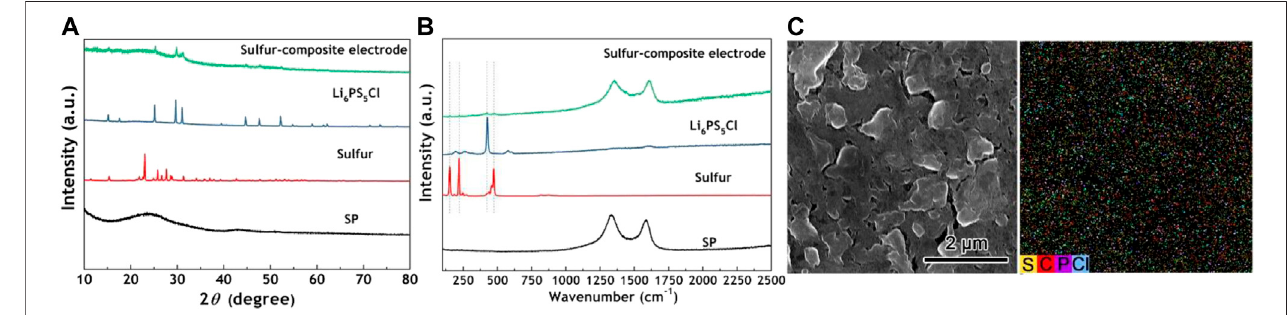
FIGURE 2 | (A) XRD patterns and (B) Raman spectra of the conductive additives (SP), sulfur, Li 6 PS 5 Cl, sulfur-composite electrode (C) The SEM image and corresponding elemental mappings of sulfur-composite electrode.